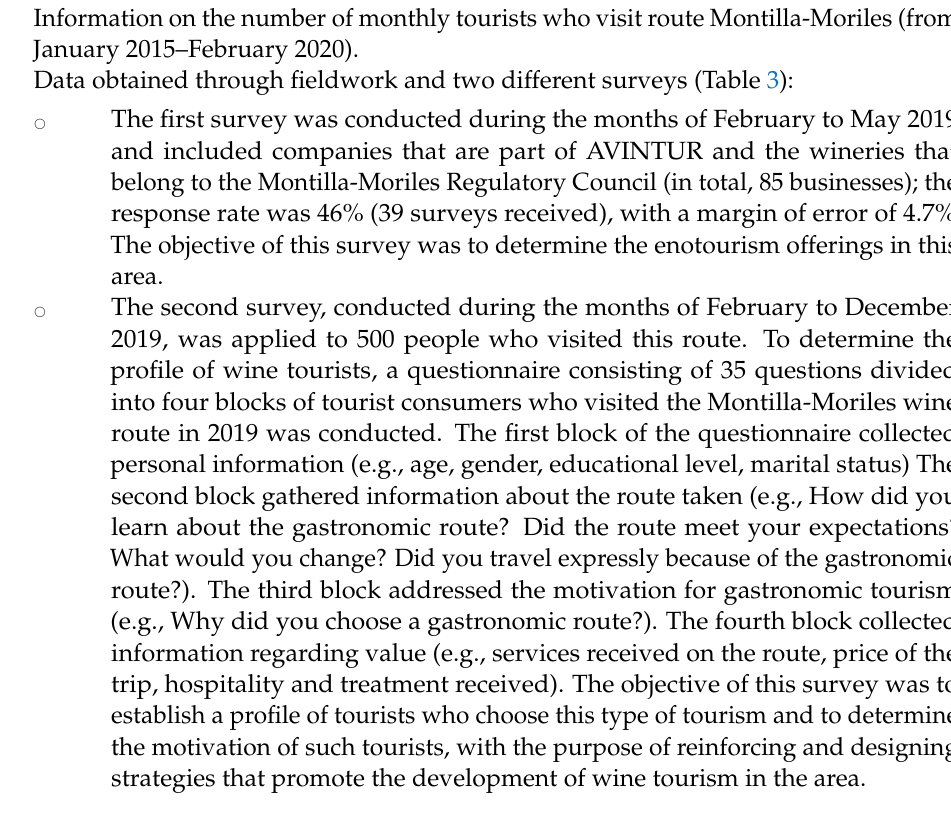
Table 3. Fact sheet for the survey.